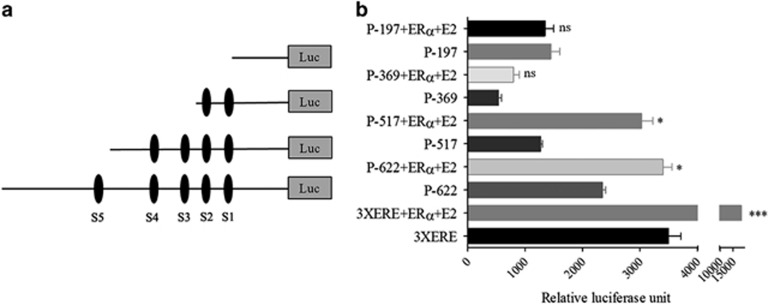
Site 3 and 4 are major response element for E2-mediated CASP7 transcription. (a) Schematic diagram of CASP7 deletion constructs. (b) The relative luciferase activity of different deletion constructs of CASP7 after post co-transfecting with ERα and E2 treatment for 48 h. The data shown are the means±s.e. of three individual experiments. *P<0.05. ***P<0.001. ns=no significant change.